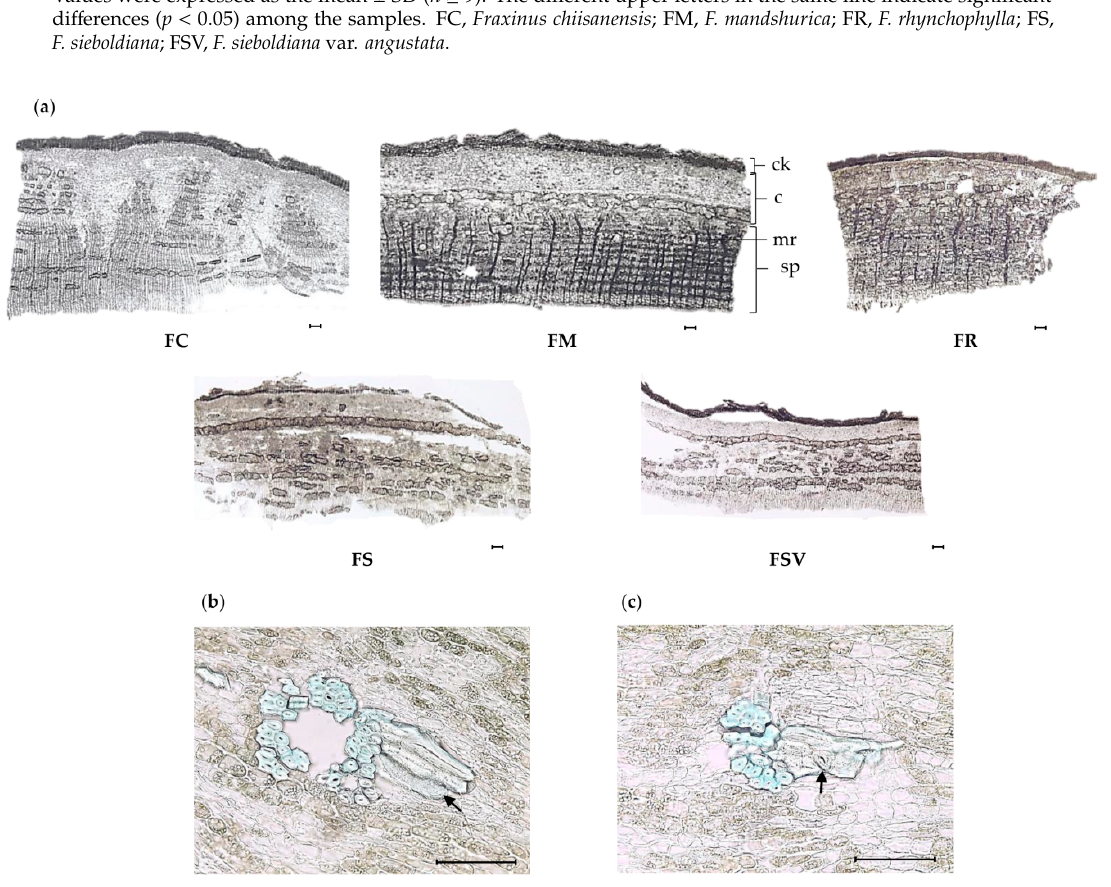
Figure 4. Photomicroscopic data of the stem bark of Fraxinus plants: ( a ) transverse section of the stem bark of four Fraxinus species and one variety ( × 40). Black bars mean 100 µ m; ( b ) idioblastic; ( c ) brachysclereids sclereids of F. mandshurica ( × 400). Black bars mean 100 µ m; ck , cork; c , cortex; mr , medullary ray; sp , secondary phloem; FC, Fraxinus chiisanensis ; FM, F . mandshurica ; FR, F . rhynchophylla ; FS, F . sieboldiana ; FSV, F. sieboldiana var. angustata . Table 4. Anatomical characteristics of the stem bark of Fraxinus plants.